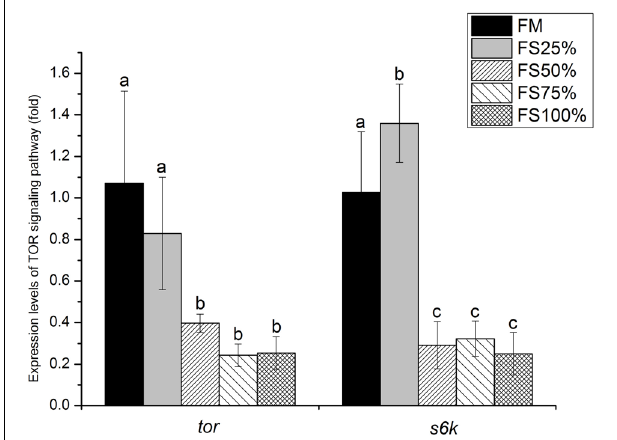
FIGURE 4 | Relative expression levels of tor and s6k in muscle of white shrimp ( Litopenaeus vannamei ) fed with five different diets. Results are shown as the mean ± SD, and different letters above a bar represent a significant difference ( P <